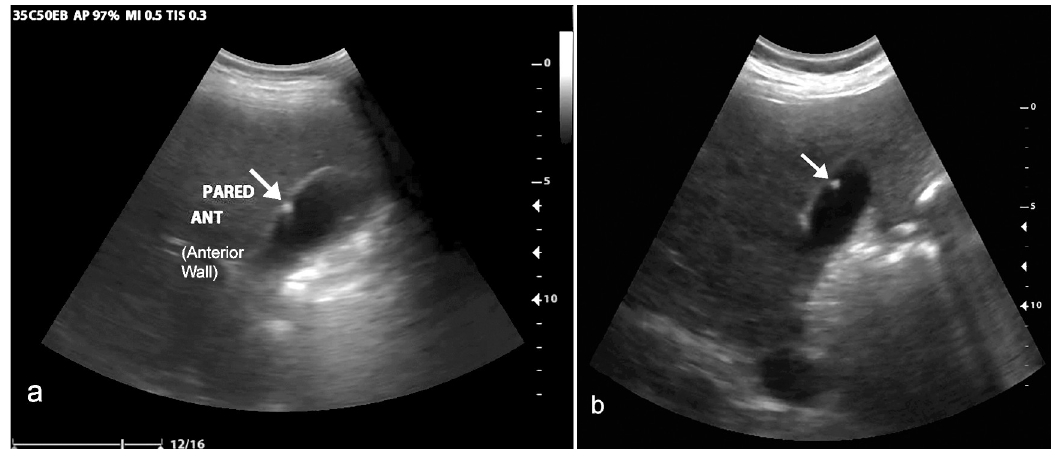
Fig 5. Gallbladder polyp. Gallbladder polyp with faint comet tail artifact seen on standard of care (a) and VSI (b).